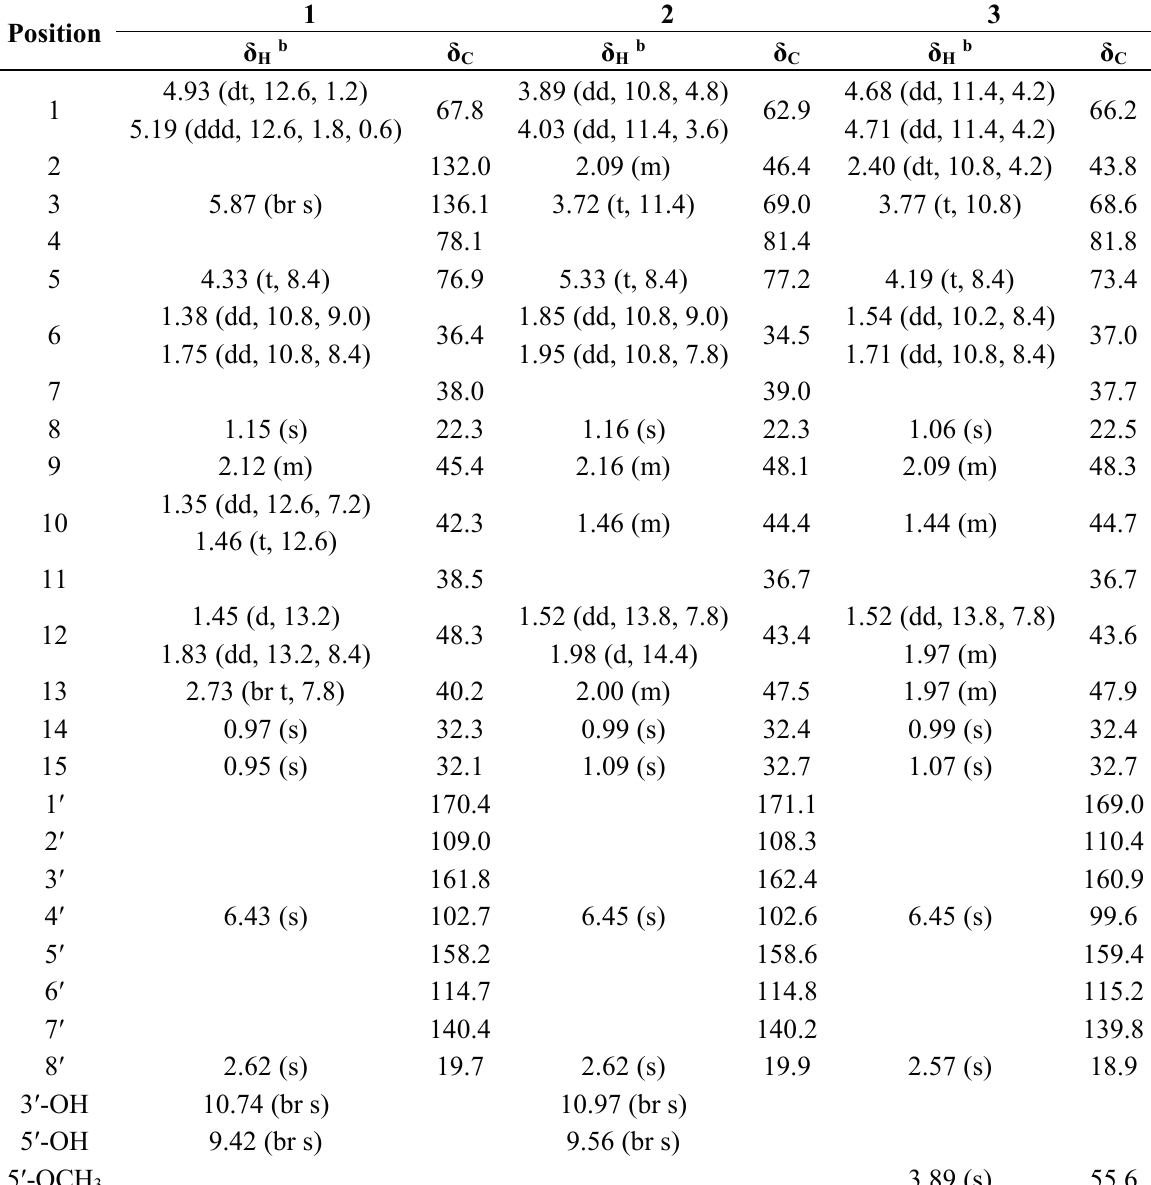
Table 1. 1 H- and 13 C-NMR data of compounds 1 – 3 in acetone- d 6 a .